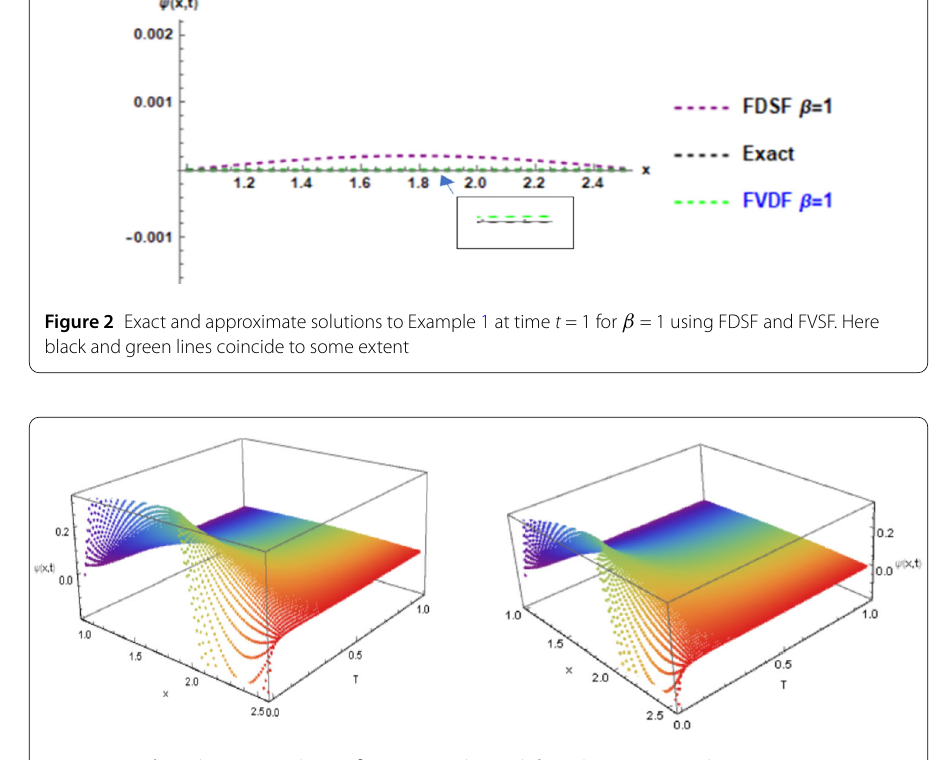
fixed h = 0.0625 and τ = 0.01. Here, h and τ are chosen small enough to